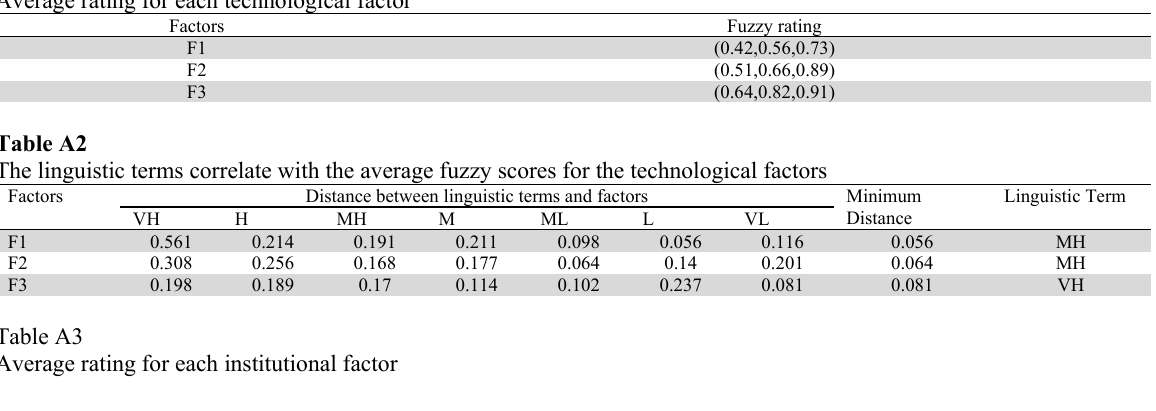
Average rating for each institutional